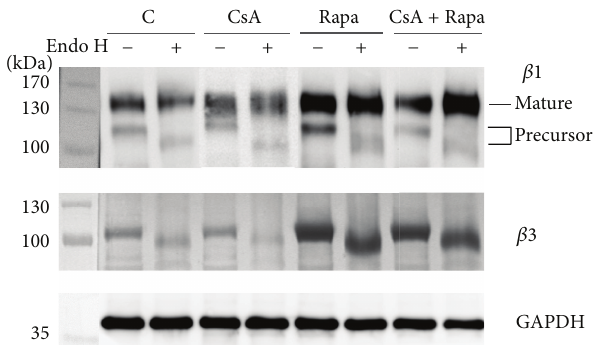
Figure 3: Rapamycin (Rapa) and the combination of cyclosporin A (CsA) and Rapa changes 𝛽 1 and 𝛽 3 integrin expression on MLR- activated cells. Peripheral blood mononuclear cells were cultured for 6 days in the presence of CsA (200 ng per 1mL medium), Rapa (20 ng per 1mL medium), and the combination of CsA (150ng per 1mL medium) and Rapa (12ng per 1mL medium) in a two-way mixed leukocyte reaction (MLR) and then lysed in RIPA buffer. Protein extracts (15 𝜇 g) were digested with endo- 𝛽 - N-acetylglucosaminidase H (Endo H) from Streptomyces plicatus , SDS-PAGE-separated on 10% gel under reducing conditions, elec- troblotted onto a PVDF membrane, and probed with specific pri- mary antibodies: mouse monoclonal anti- 𝛽 1 (Chemicon, MAB2251, clone B3B11) and rabbit polyclonal anti- 𝛽 3 (Chemicon, AB1932). Antibody-bound integrins were visualized by chemiluminescence. GAPDH was the endogenous control. C: untreated cells.